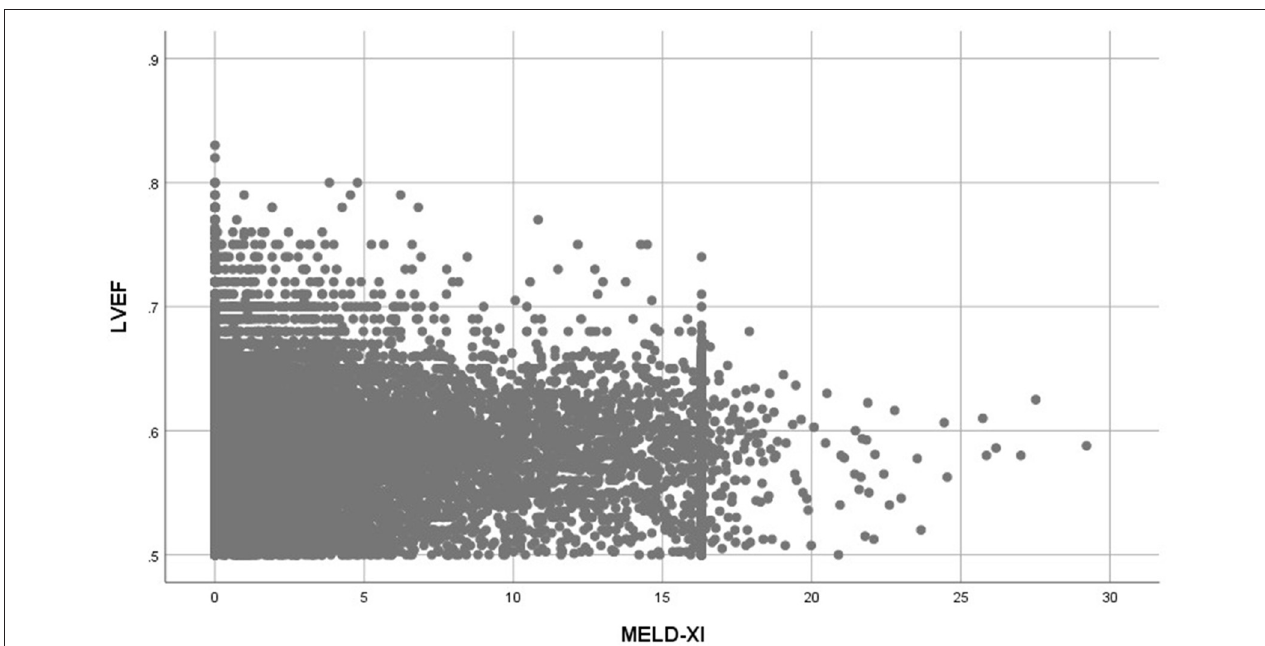
FIGURE 3 | Scatter plot between LVEF and MELD-XI score.